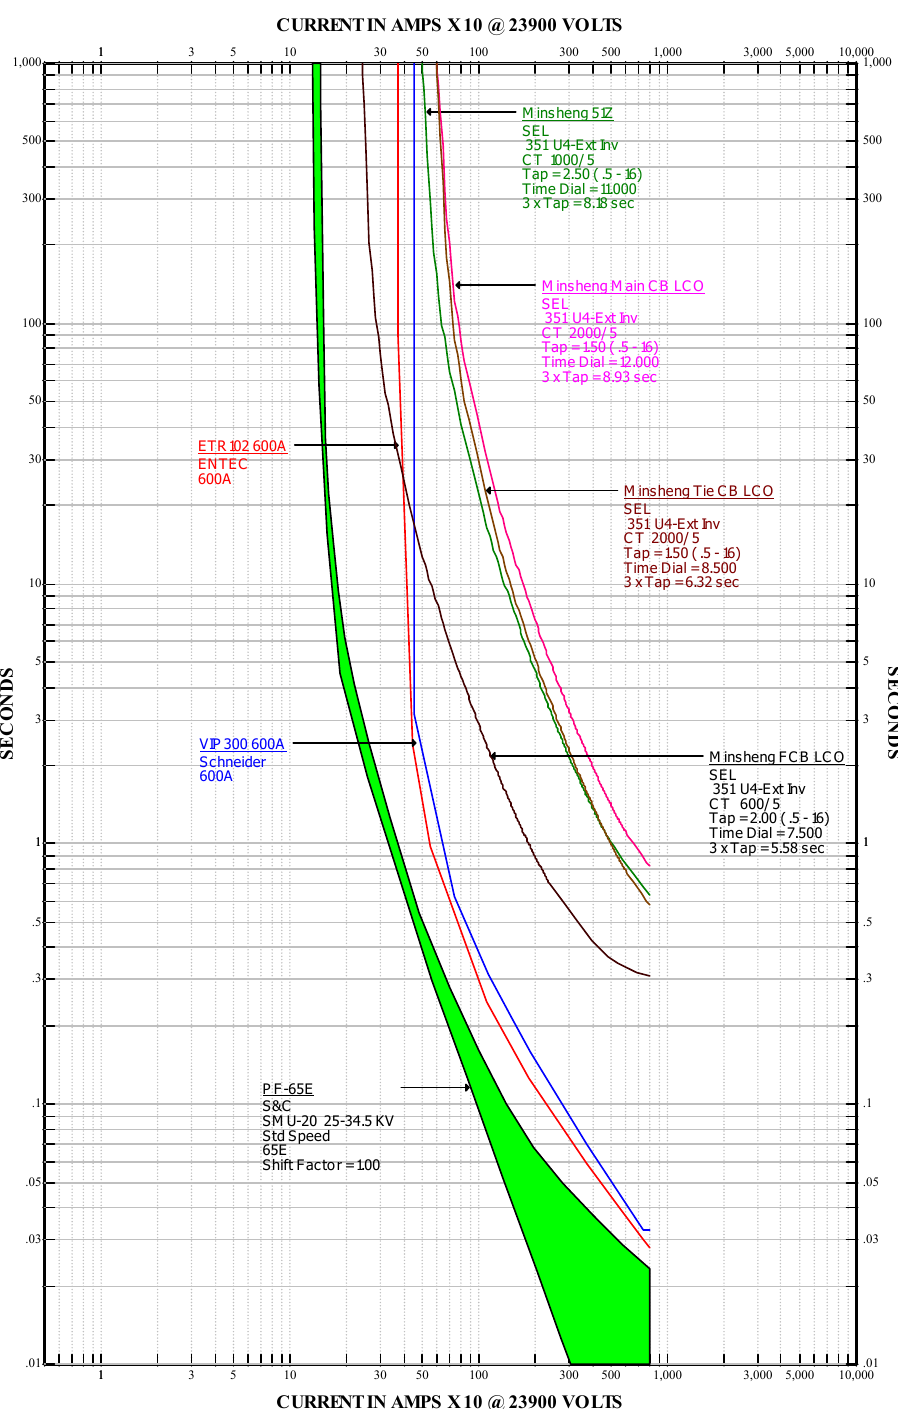
Figure 8. Original LCO relays of Minsheng